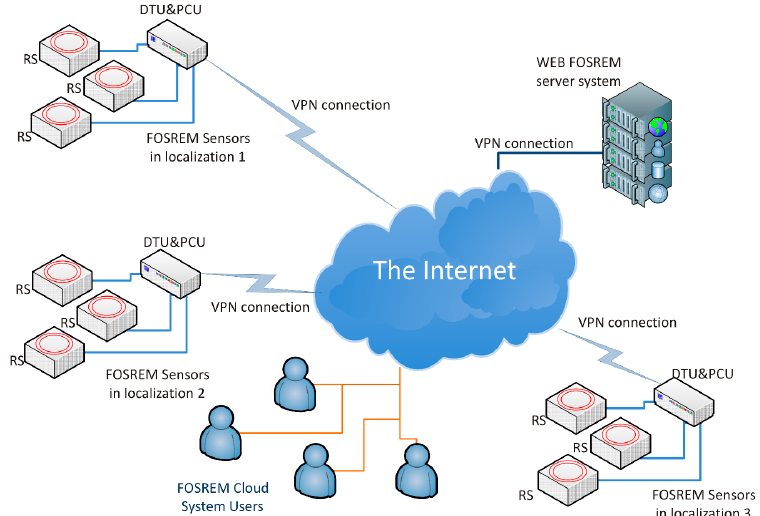
Figure 1. The Fiber-Optic Rotational Seismograph (FOSREM ® ) cloud system with samples FOSREM Sensors localization [16]. DTU: data transmission units. PCU: power communication units. VPN: virtual private network.